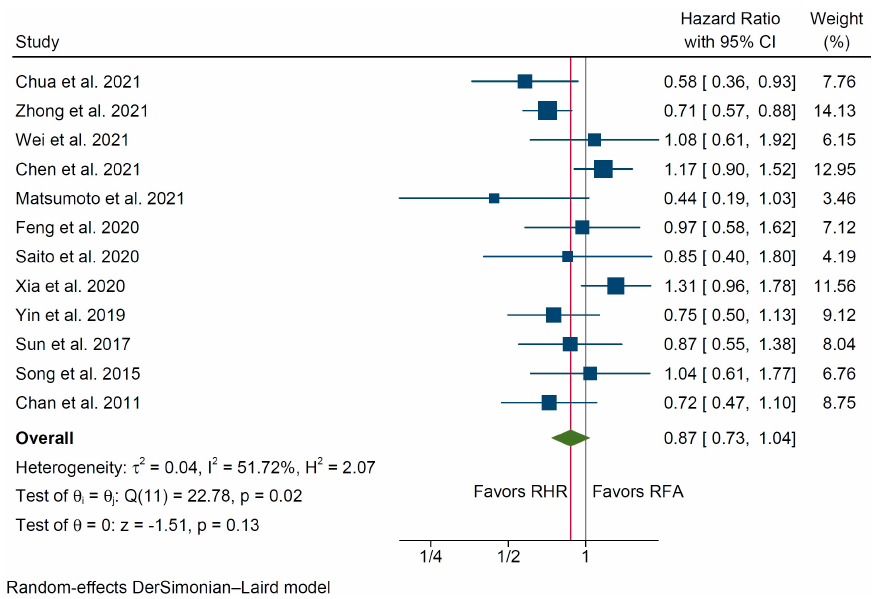
Figure 2. Forest plot for Overall Survival of patients undergoing repeat hepatic resection (RHR) versus radiofrequency ablation (RFA) of recurrent hepatocellular carcinoma [22–38].